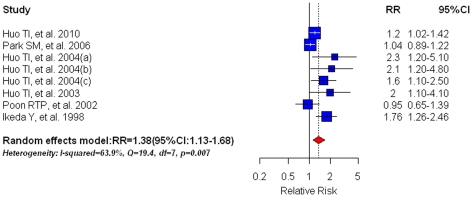
Summary estimate of relative risk (RR) for all-cause mortality in HCC patients with pre-existing diabetes mellitus compared with their non-diabetic counterparts.Squares represent study-specific estimates (size of the square reflects the study-specific statistical weight, i.e. inverse of the variance); horizontal lines represent 95% CIs; diamonds represent summary estimates with corresponding 95% CIs.